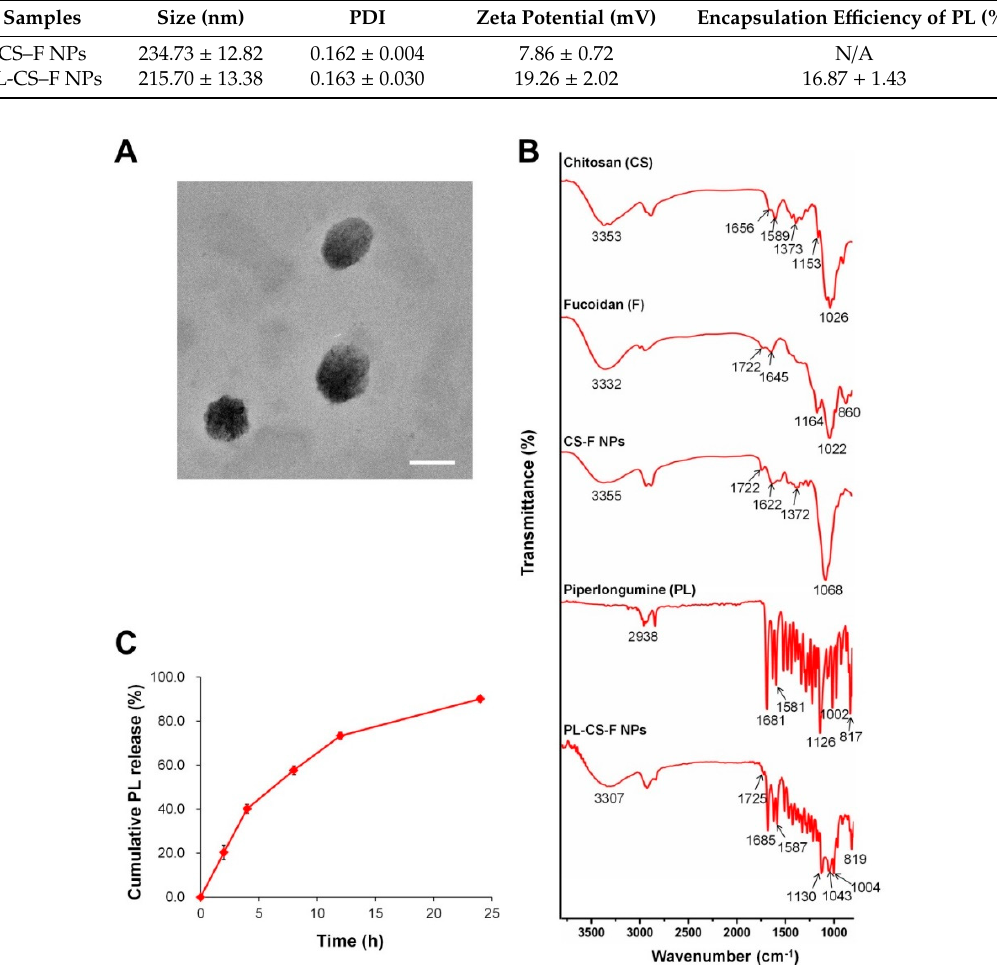
Figure 2. ( A ) TEM image of PL-CS–F NPs. Scale bar = 200 nm. ( B ) FT-IR spectra of chitosan, fucoidan, CS–F NPs, PL, and PL-CS–F NPs. ( C ) Drug release profiles of PL-CS–F NPs in phosphate buffered saline (PBS) (pH 7.4) at 37 °C for 24 h.